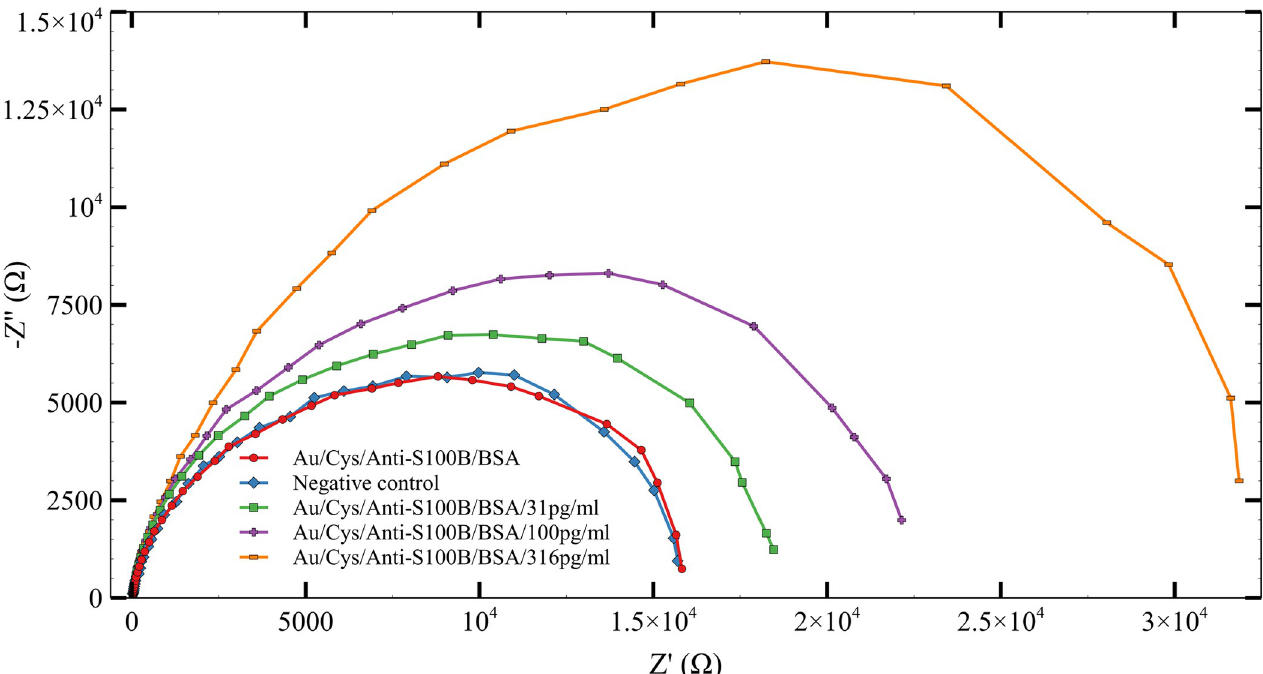
Fig 10. Nyquist plots of AUIDEs experimental results in spiked human plasma samples for the quantification of S100B in the 31–316 pg/mL range.